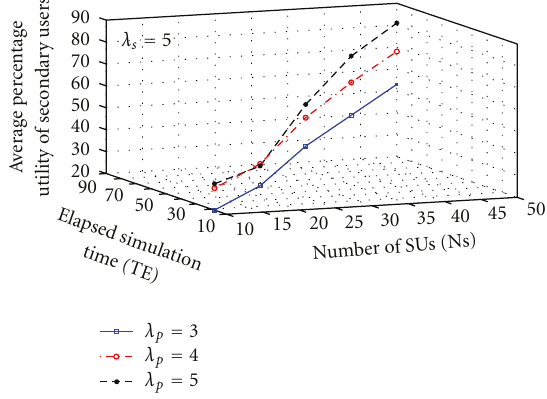
Figure 10: Percentage utility values of SUs at di ff erent time in-